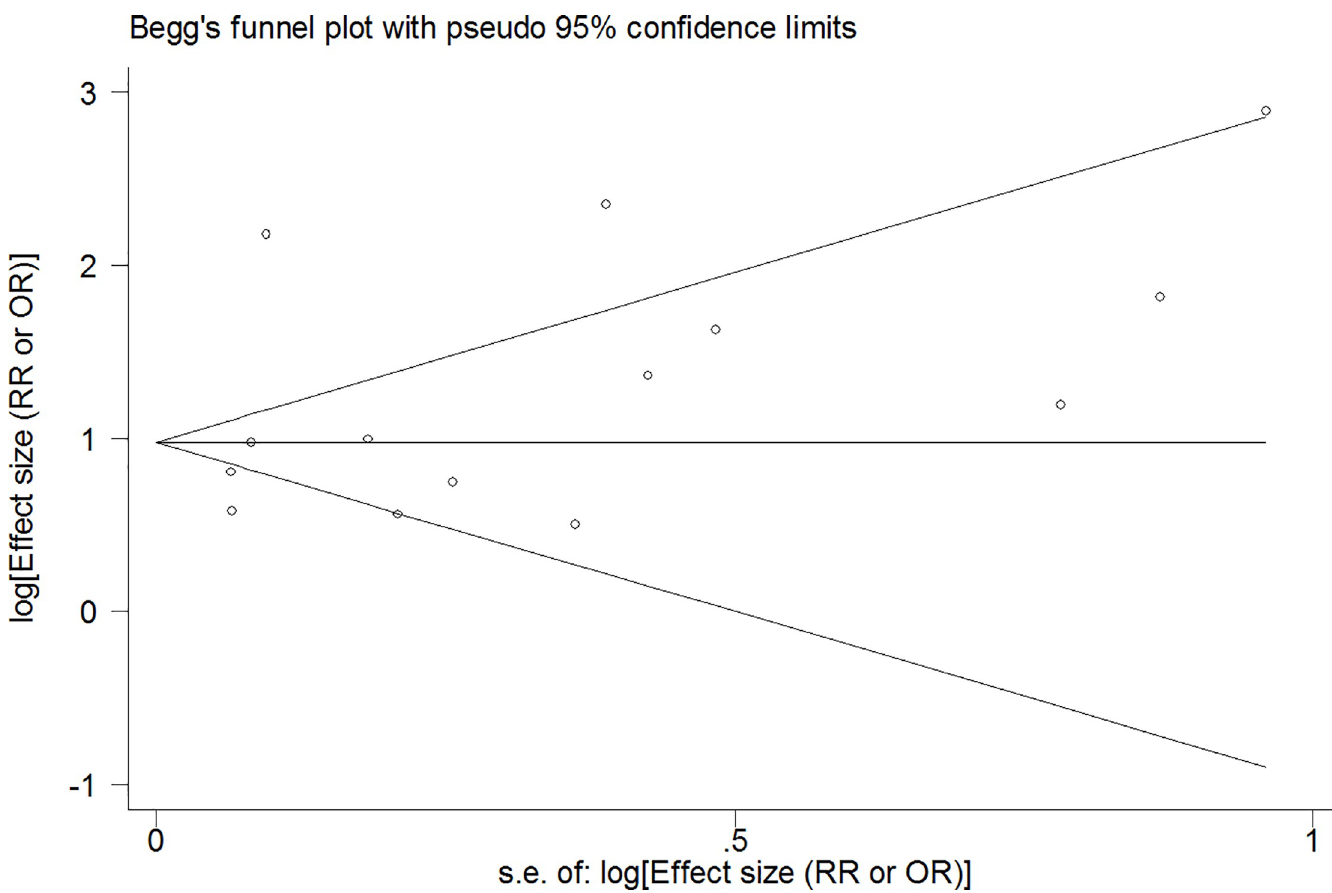
Fig 6. Funnel plot of included studies assessing the publication bias in studies addressing the association between alcohol use disorder and suicide attempt.